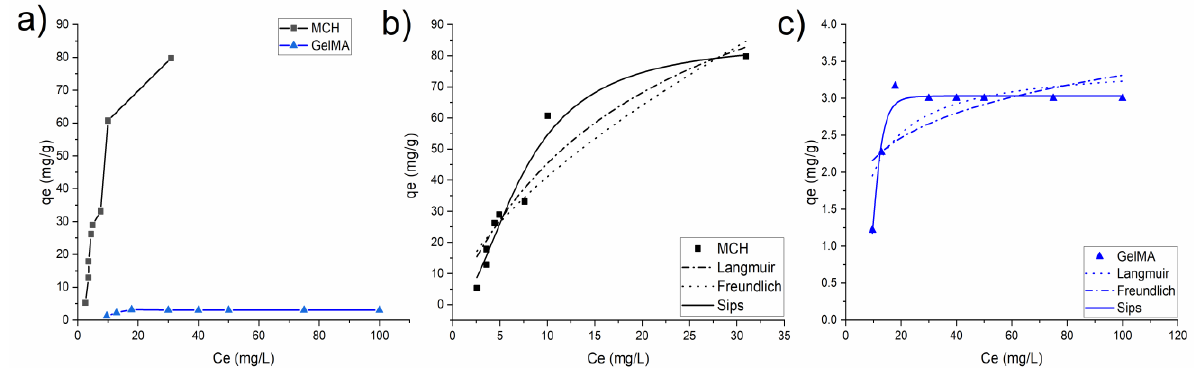
Figure 8. ( a ) Isotherm plots of MCH and GelMA hydrogels obtained from the experimental data; ( b ) MCH and ( c ) GelMA isotherm values fitted with different isotherm models. Table 3. Adsorption isotherm parameters for As(V) adsorption on MCH and GelMA at pH = 6. Langmuir